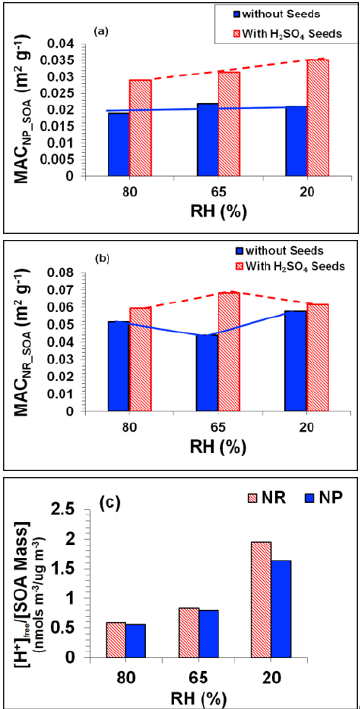
Figure 14. ( a – c ): Effects of water vapour and acidity on the MAC of toluene SOA. ( a ) MAC of NP SOA for the H 2 SO 4 seeded and non-seeded experiments at the three RHs; ( b ) MAC of NR SOA for the H 2 SO 4 seeded and non-seeded experiments at the three RHs; ( c ) concentration of [H + ] (free acid) per unit SOA mass available in aqueous for heterogeneous chemistry at the three RHs. The solid and dashed lines are eye guides.